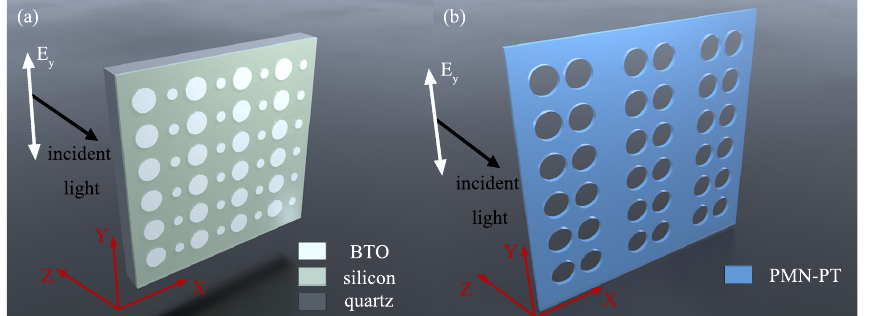
Figure 1. ( a ) A sketch of the proposed E-field sensor based on nano-patterned thin film silicon on quartz where the air holes are filled with BTO nanoparticles. ( b ) A schematic of the proposed E-field sensor which is made of nano-patterned free standing PMN-PT thin